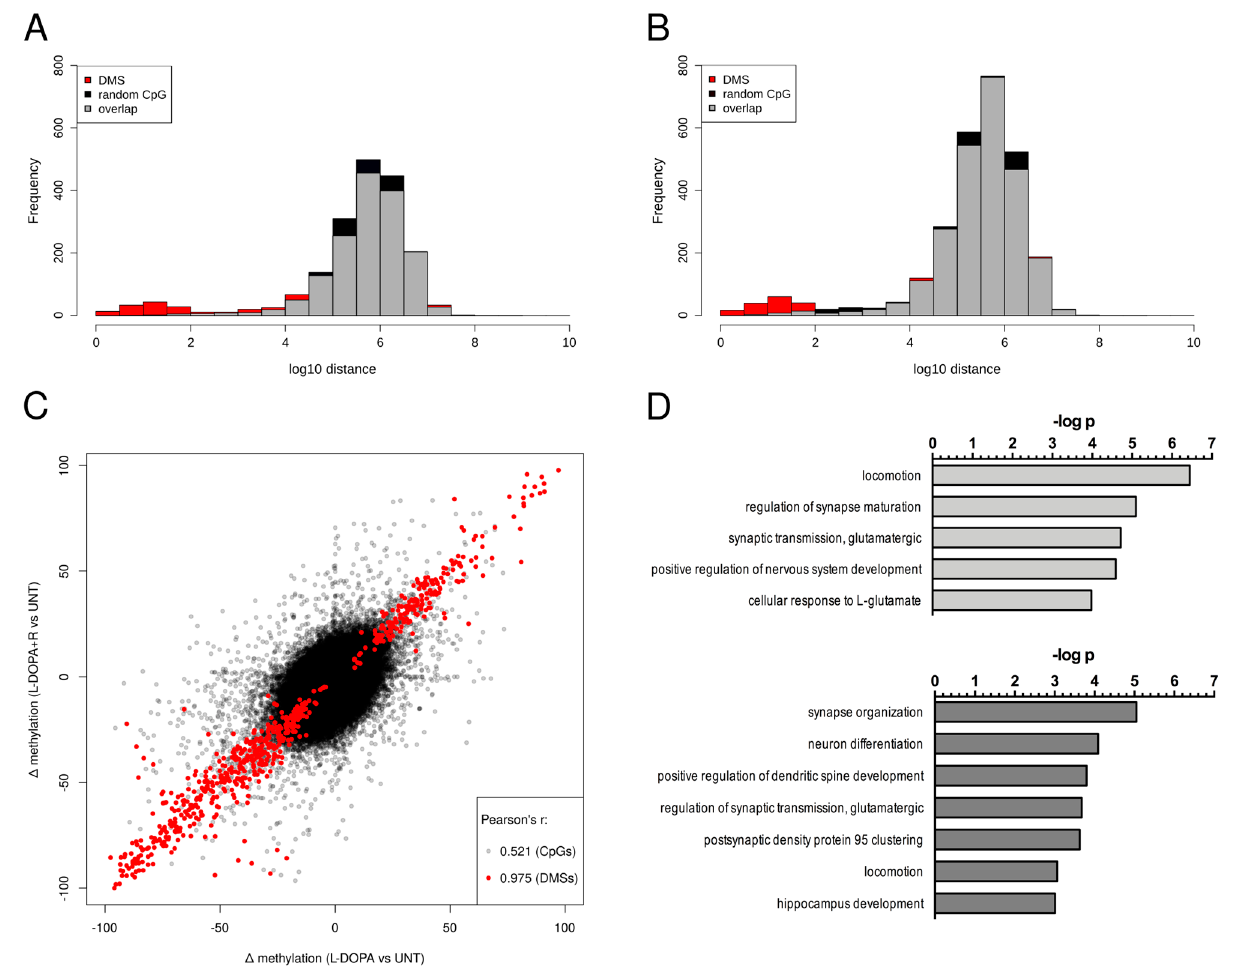
Figure 3. Characterization of DMS. ( A , B ) Distribution of genomic distances between neighboring DMS in L-DOPA vs. UNT and L-DOPA + R vs. UNT groups shown in red. The average of 100 random distributions of genomic distances of the same number of CpGs is shown in black. The overlap is shown in grey. The small difference in the shape of the random distributions between the two panels is due to the higher number of DMS in the L-DOPA + R vs. UNT comparison leading to shorter average distances between two random CpGs. ( C ) Scatter plot of CpGs present in both L-DOPA vs. UNT and L-DOPA + R vs. UNT comparisons. The plot shows the methylation changes in the treated animals of each CpG relative to the UNT animals. The red dots indicate CpGs, which are DMS in both comparisons. Pearson’s R values are also shown in grey and red. ( D ) shows the results of the GO term enriched analysis performed using DMS detected in L-DOPA vs. UNT ( upper panel ) and L-DOPA + R vs. UNT ( lower panel ) comparisons.